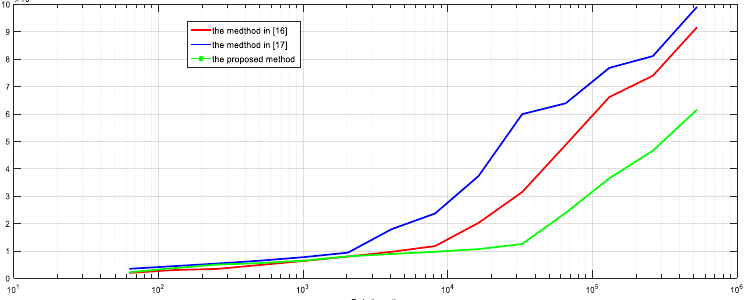
Figure 14. Comparison of the computational complexity of the algorithms proposed in [16,17] and this paper.